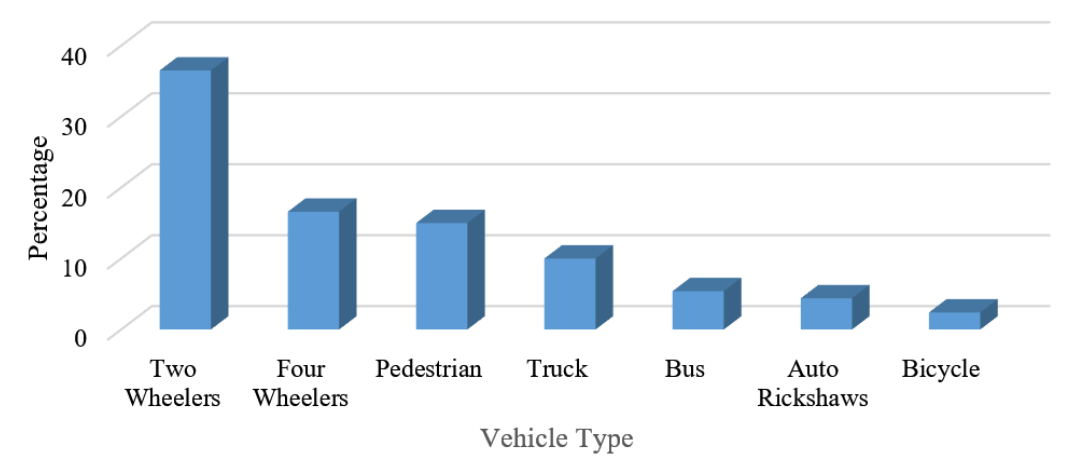
Figure 4: Persons killed in terms of road user category